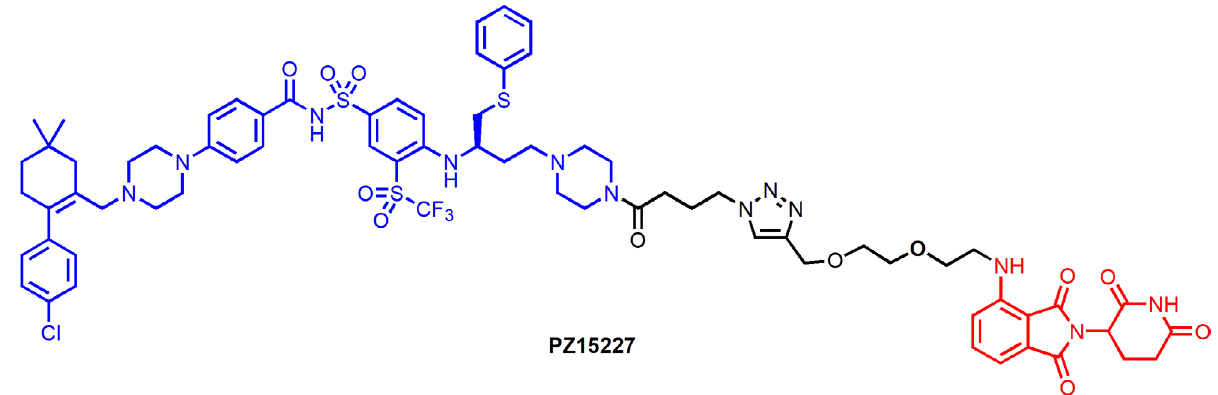
Figure 8. Chemical structure of PZ15227 that recruits CRBN E3 ligase for BCL-X